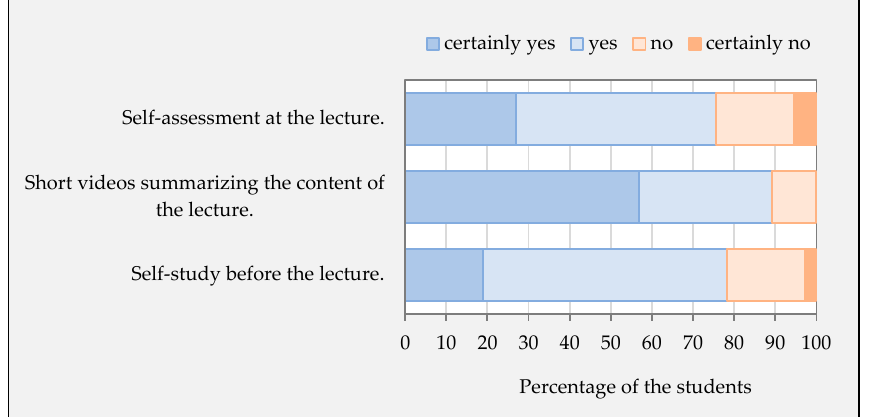
Figure 14. Students’ suggestions for lecture redesign.